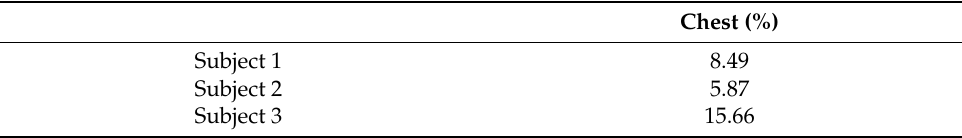
Table 7. The average deviation of the force.